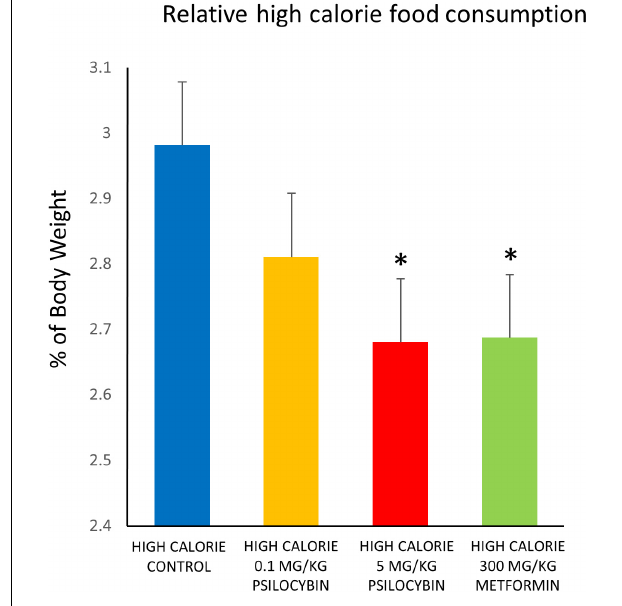
FIGURE 2 | Effects of chronic psilocybin or metformin on mean daily food consumption, as percentage of body weight. Data represent mean consumption of high calorie cafeteria diet, expressed as percentage of body weight, averaged across the 27 days of treatment. Rats were fed the high calorie cafeteria diet during weekdays only. Amount of high calorie diet food (excluding regular rat chow) consumed after each day of treatment was measured (g) and calculated as% of individual body weight (g) for that particular day. Adult male rats ( n = 14–16 per group) were treated chronically with low (0.1 mg/kg i.p.) or high (5 mg/kg i.p.) doses of psilocybin, metformin (300 mg/kg p.o.), or vehicle (0.9% saline solution), and fed high calorie diet. Does not account for consumption of regular rat chow. Values are group means ± SEM. ∗ Statistically different from high calorie diet control group, p < 0.05.